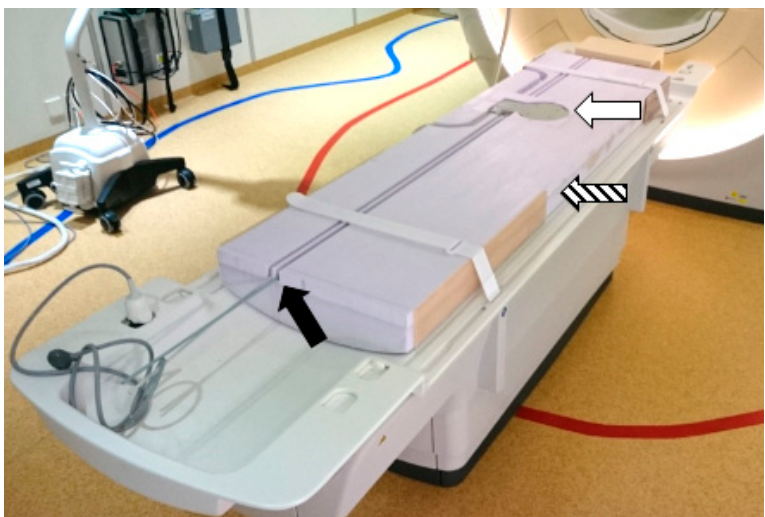
Figure 1. Experimental setup for measuring phosphorus-31 magnetic resonance spectroscopy (31P MRS) at 3 T, within the spinal erectors. A custom platform was built (striped arrow) to fit on the scanner table. This platform allowed the participants to lie flat on their backs with the phosphorus transmit/receive coil lowered into the platform (white arrow). Underneath the coil, a cavity housed the external cylindrical reference. Spaces were also made for the tuning and matching control rods (black arrow).